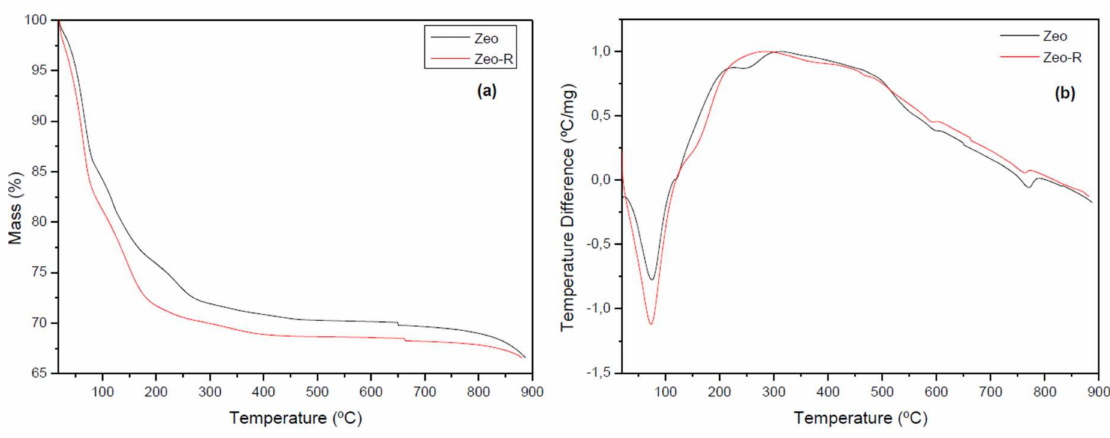
Figure 2. Thermogravimetric ( a ) and differential thermal ( b ) analysis curves of the zeolites prepared from white and red kaolins.